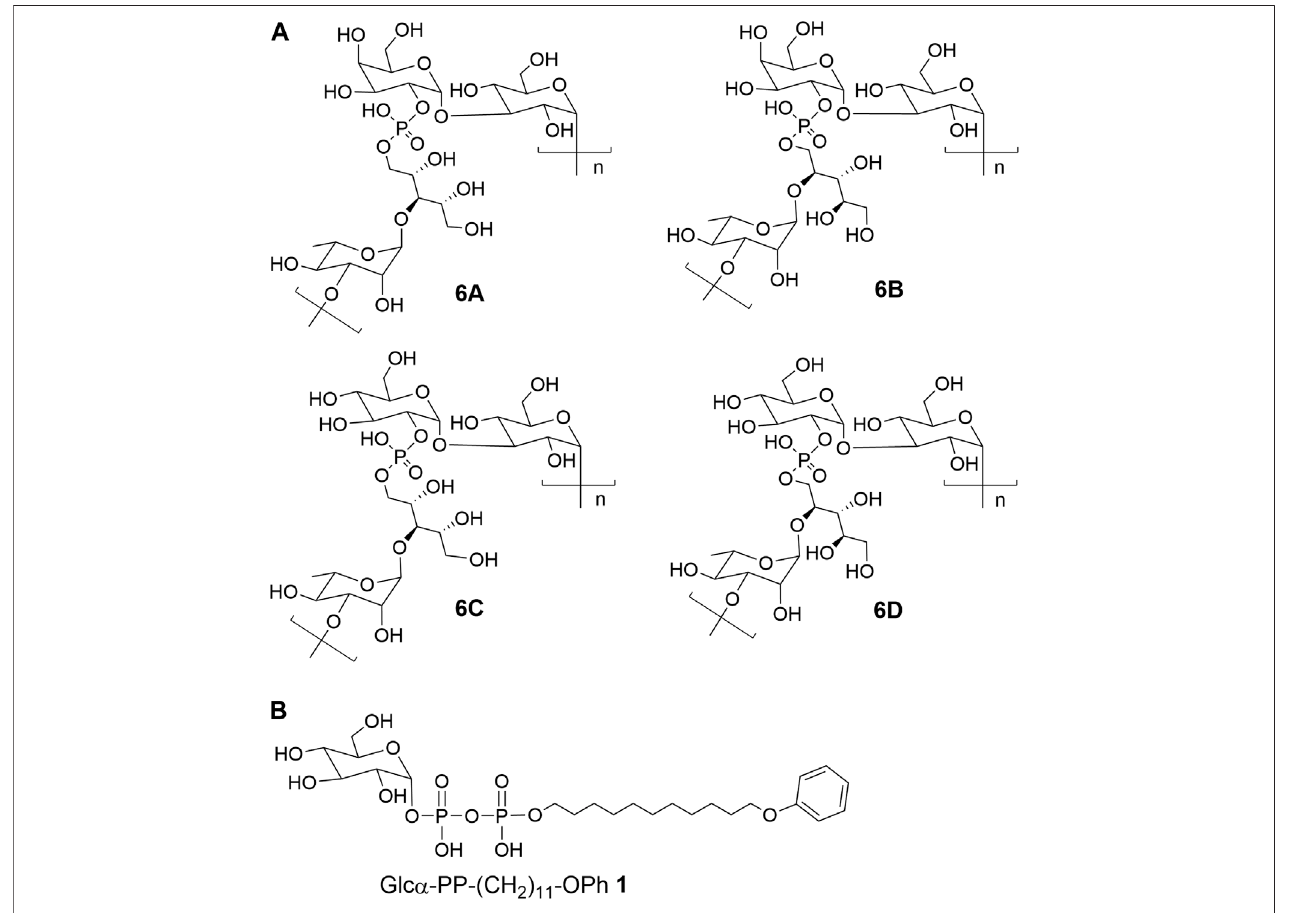
FIGURE 1 | The chemical structures of (A) CPS repeat units of pneumococcal serotypes 6A – D and (B) the glycolipid Glc α -PP-(CH 2 ) 11 -OPh 1 .